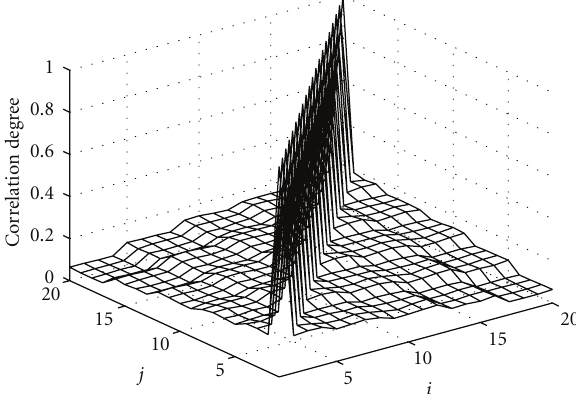
Figure 2: Average magnitude of correlation coe ffi cient between e ff ective noise samples, N T = N R = 4, L = 4, BPSK mapping, and E b /N 0 = 4